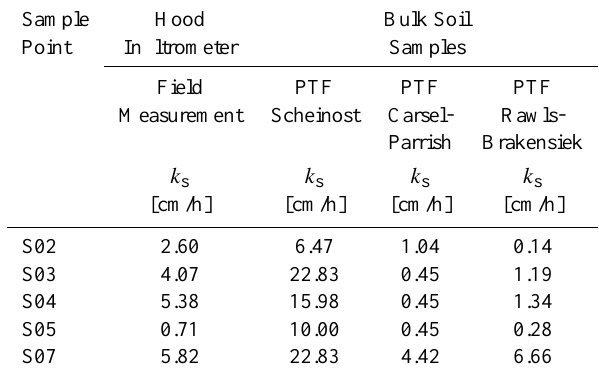
Table 7. Saturated hydraulic conductivity k s from bulk soil sample analysis and application of different